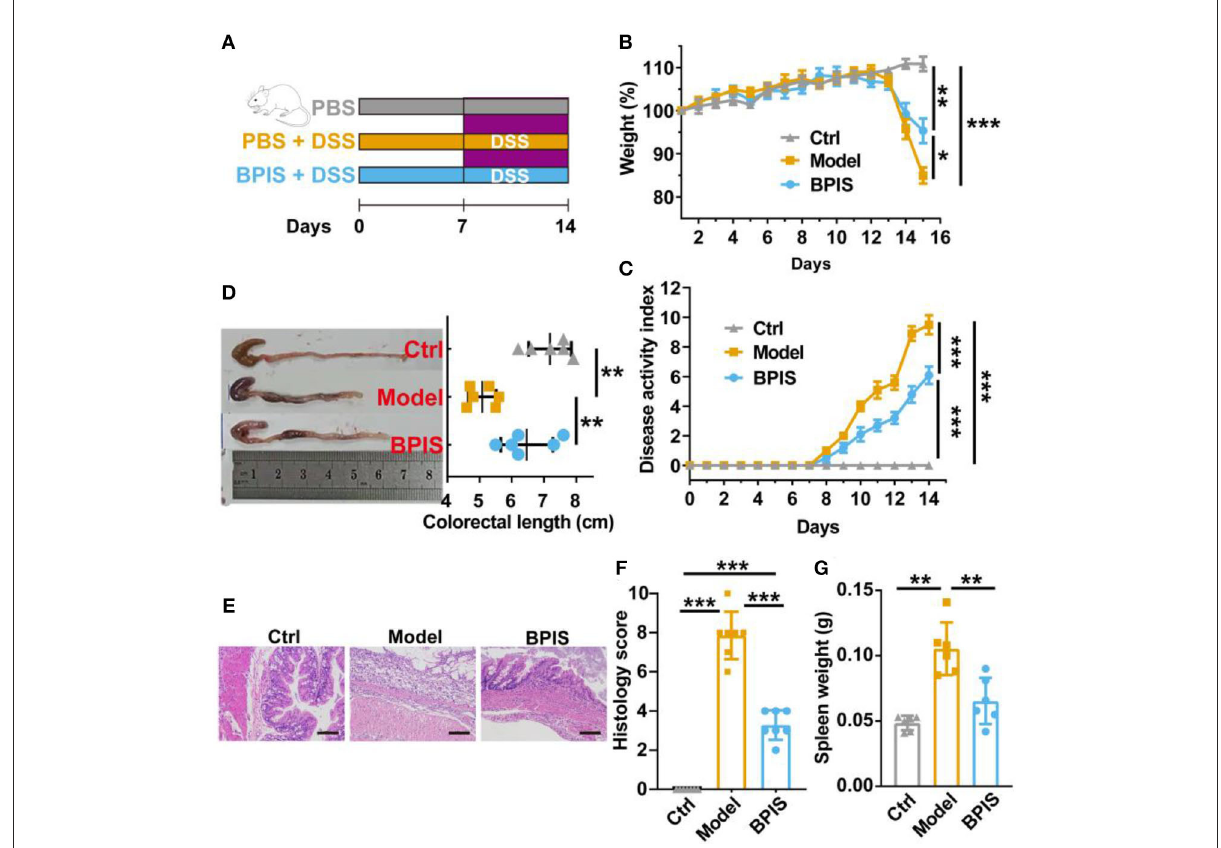
FIGURE1 BPIS relieves dextran sodium sulfate (DSS)-induced colitis. Mice were gavaged with bound polyphenol of the inner shell (BPIS) extracted from foxtail millet bran for 2 weeks. Colitis was induced by administering 3% DSS dissolved in drinking water for 7 days. (A) Study design of the in vivo mouse experiment. (B,C) Percentage changes in body weight, and disease activity scores (DAI). (D) Colon lengths in differential groups and representative images of mice colons. (E,F) Representative hematoxylin and eosin (H&E)-stained histologic images, and comprehensive histology scores of the colon of experimental mice. Scale bars, 100 µ m. (G) Spleen weight. Data are presented as the means ± SD (n ≥ 5) and were analyzed by an ordinary one-way ANOVA with Tukey’s multiple comparisons. * p < 0.05, ** p < 0.01, *** p <